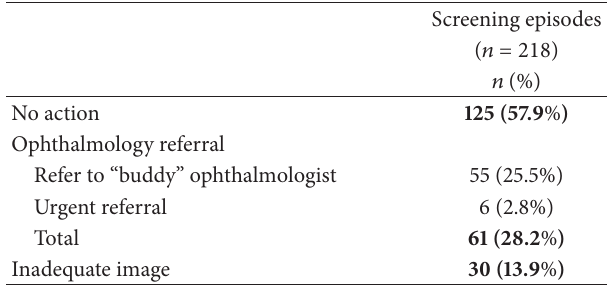
Table 5: GP management